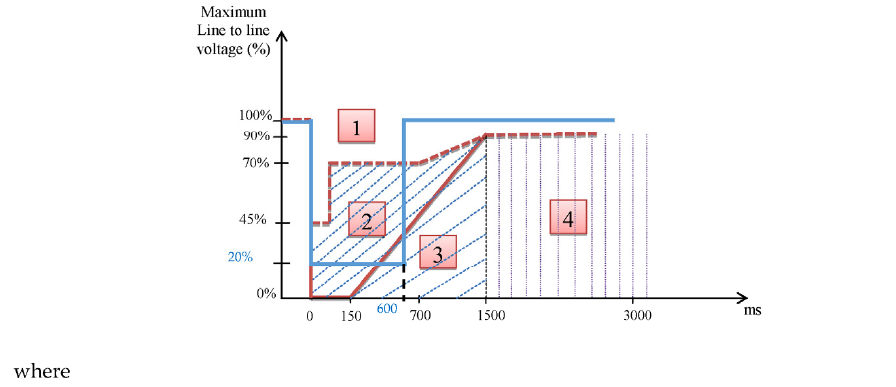
Figure 6. Fault ride-through requirement voltage profile given by E. ON, Netz and GCM [22,23]. When the grid voltage is oriented on the d-axis ( v qg = 0), the active and reactive electricity supplied into the grid may be adjusted by utilizing the quadrature and the direct component currents from (8), resulting in (16):